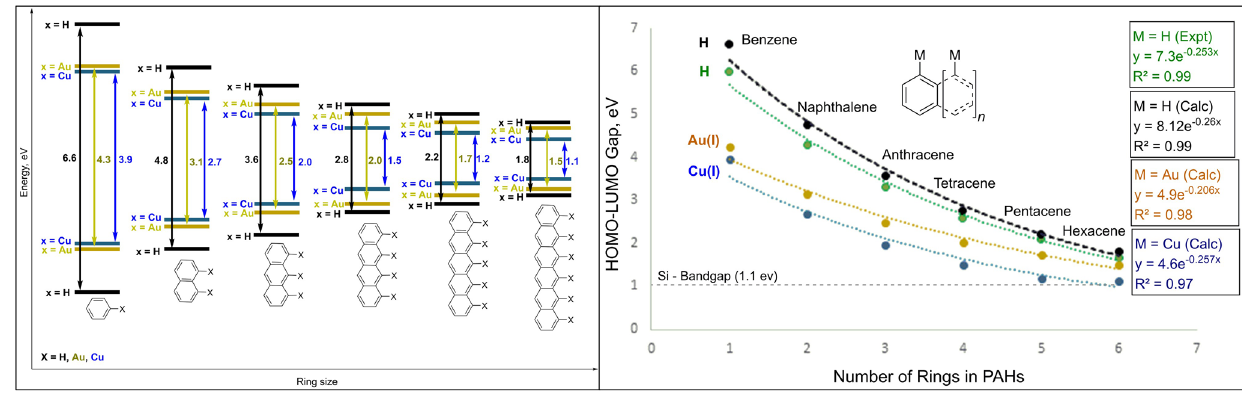
Fig. 17 Comparing the bandgaps of unsubstituted and transition metal-substituted polyacenes. Left: Bandgaps as a function of the number of rings in unsubstituted, Au(I)-substituted, and Cu(I)-substituted polyacenes. Right: Exponentially declining bandgaps as a function of the number of delocalized p-bonds in unsubstituted, Au(I)-substituted, and Cu(I)-substituted polyacenes. The green and black plots on the right correspond to experimental and DFT-calculated bandgap, respectively. All calculations were performed using the